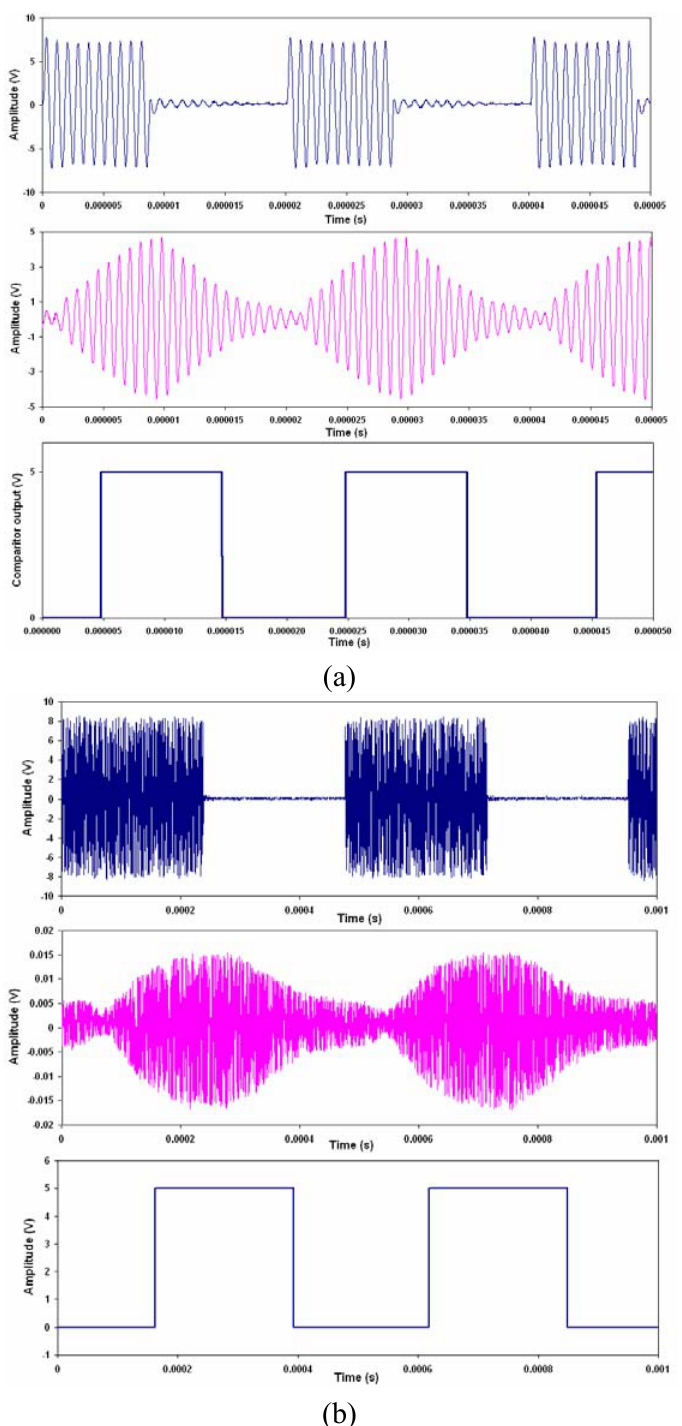
Figure 9. ASK OOK communications signals for (a) Al-PZT, (b) Al-FBG; showing transmitted (top) , received (middle) and decoded (bottom)